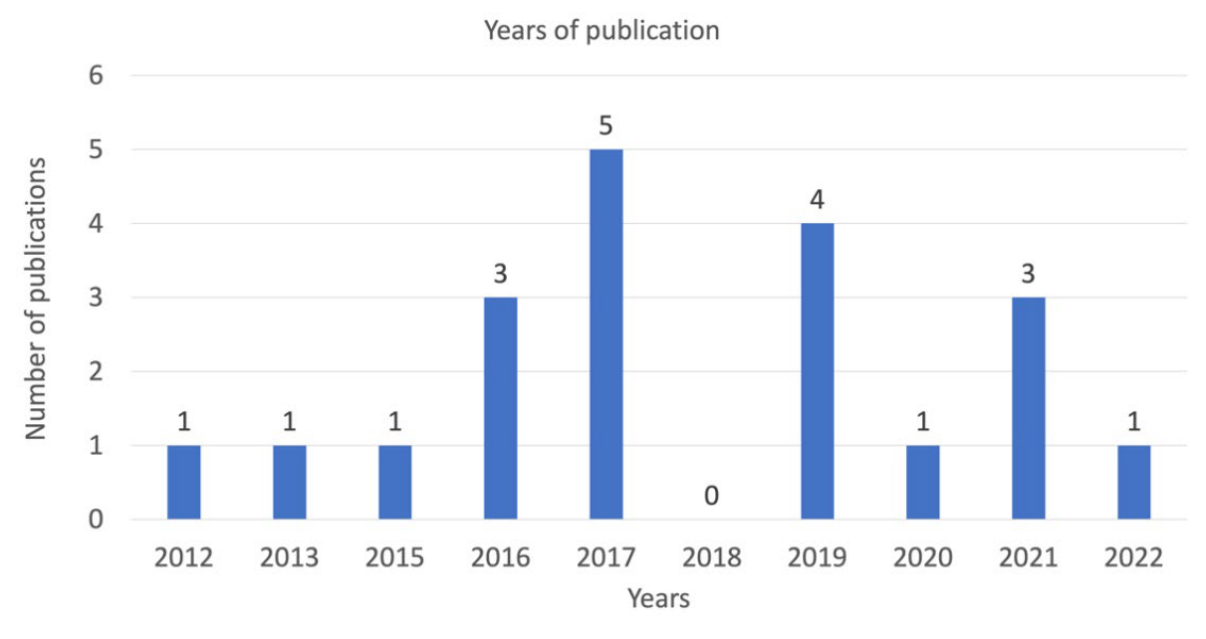
Figure 2. Number of papers per year.